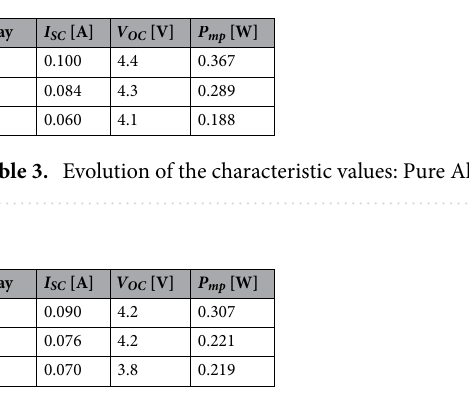
Table 4. Evolution of the characteristic values: Polished Aluminium (Plate 3).